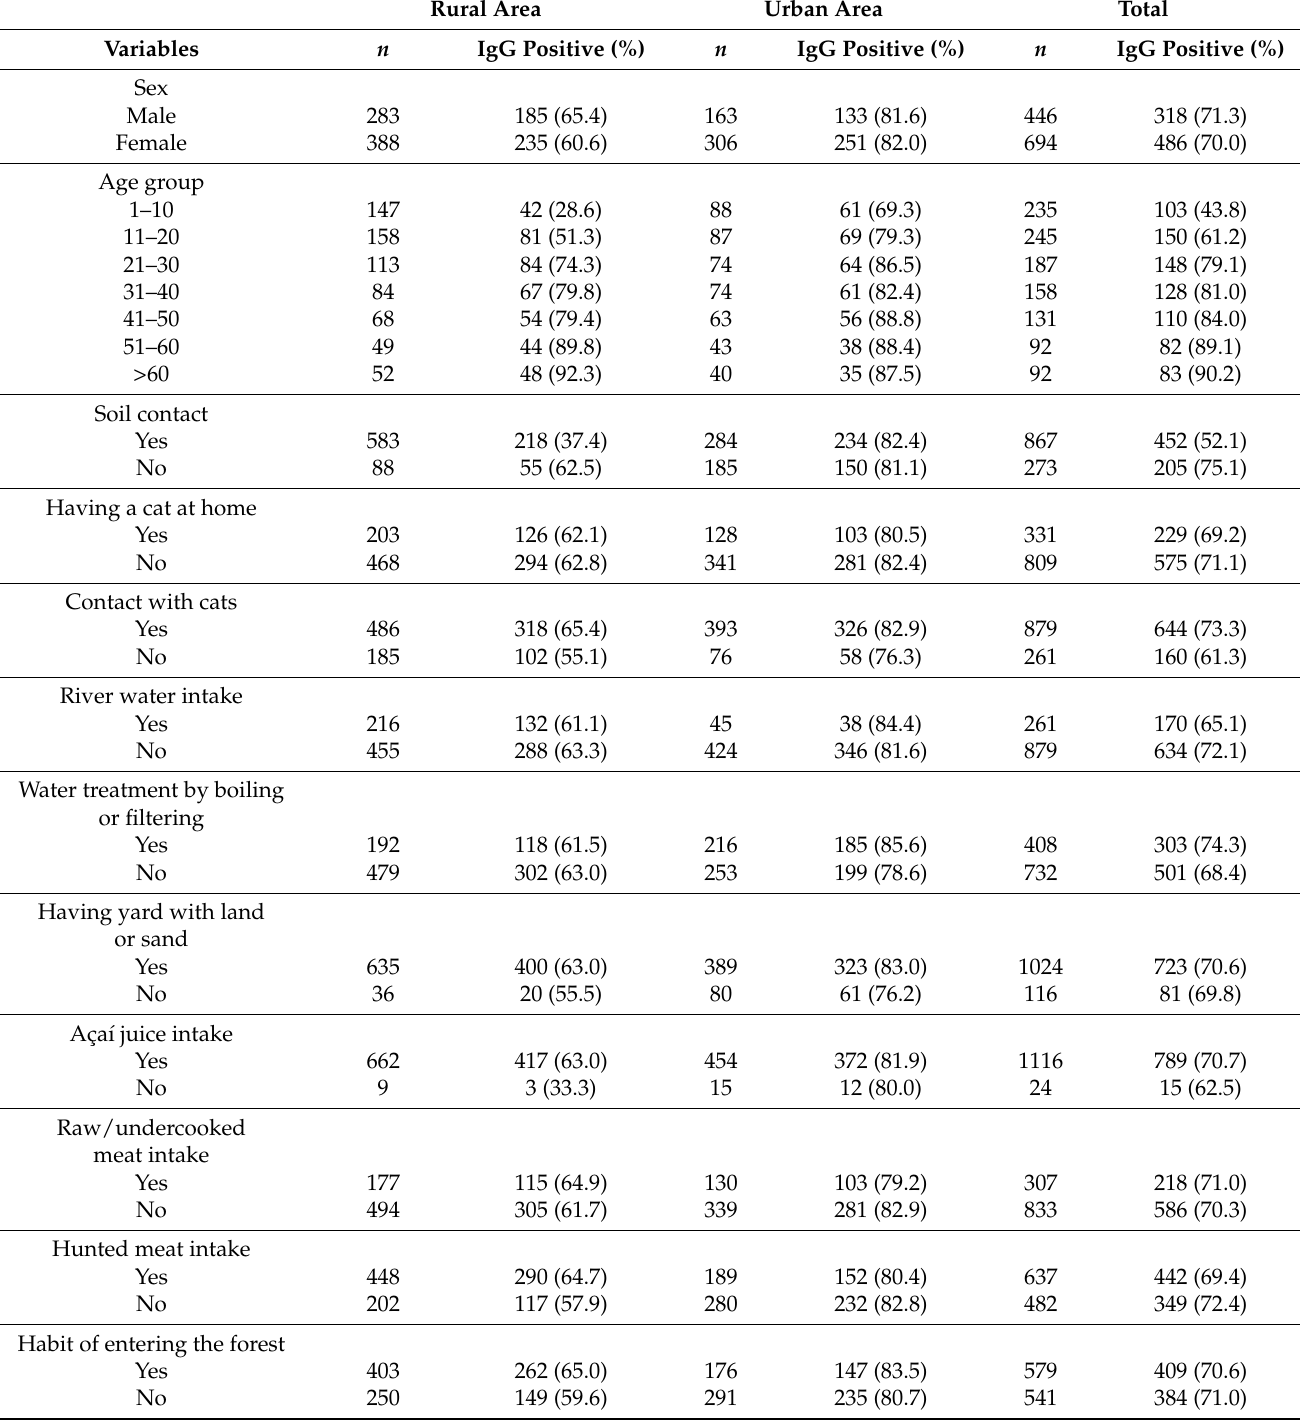
Table 1. Variables studied and seropositivity of IgG anti- T. gondii in individuals residing in the municipality of Ponta de Pedras, Par á , Brazil, from August 2015 to April 2018. Rural Area Urban